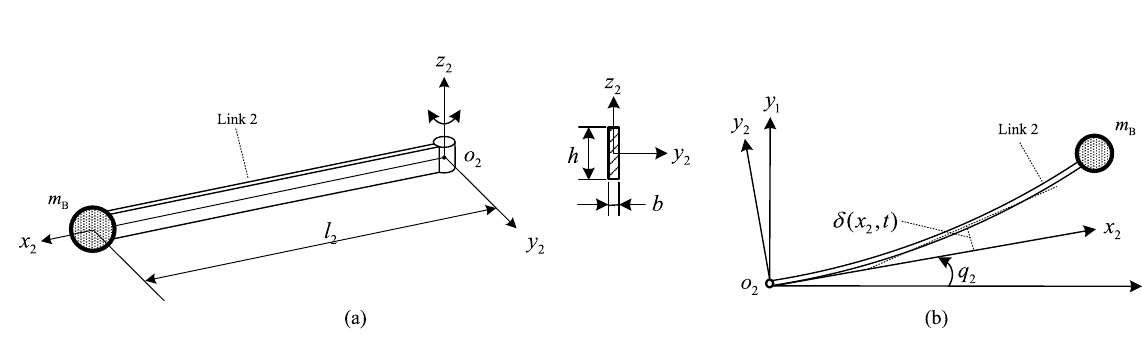
Fig. 1. Model of the flexible manipulator.